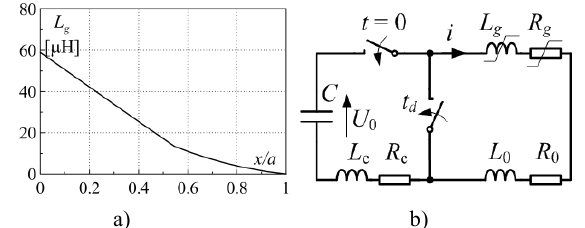
Fig. 3. Characteristics of the FCG inductance L g as a function of its dimensionless length (a) and the parametric circuit of the FCG model (b).